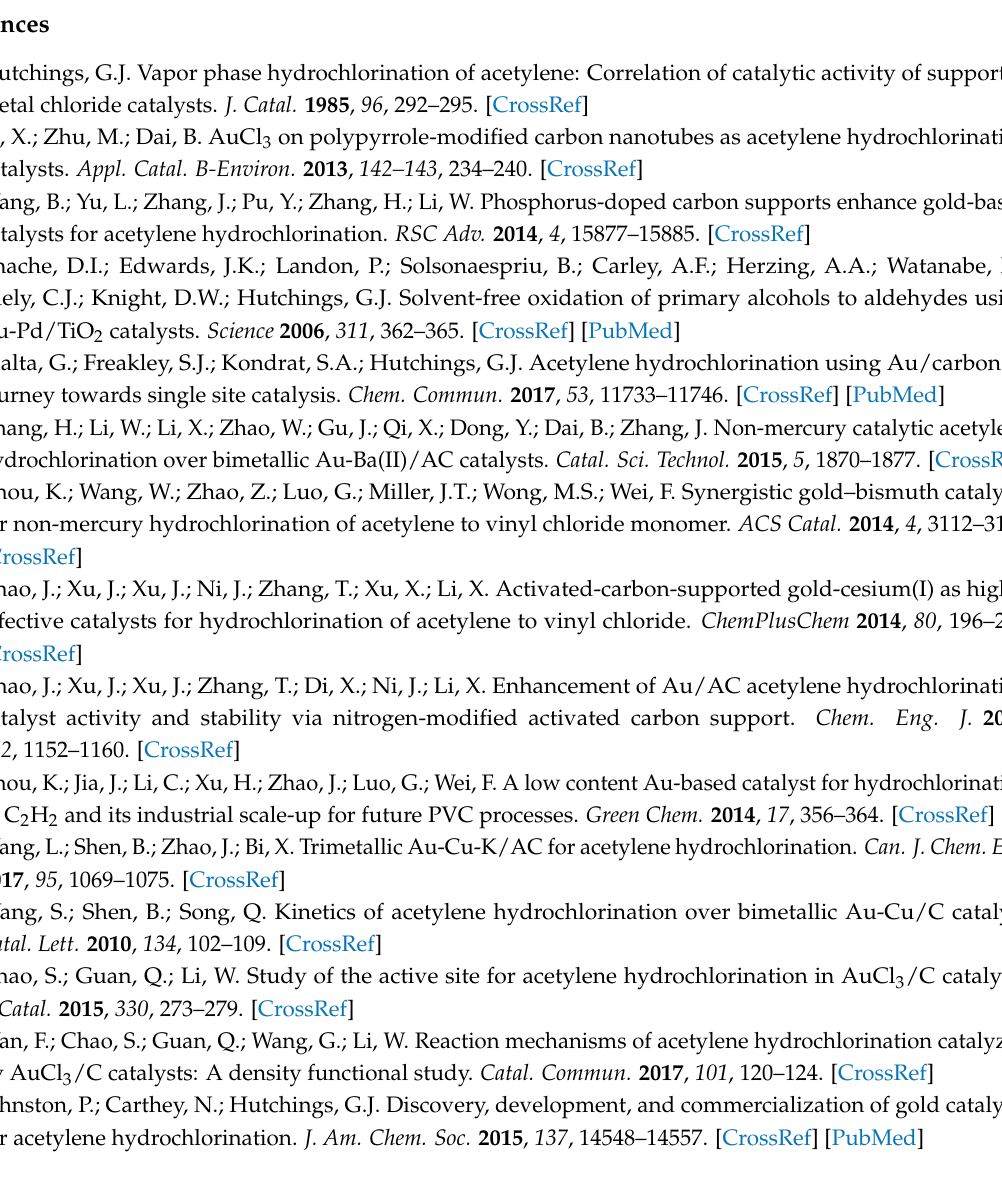
Table S3: Comparative study for the catalytic efficiency of this catalytic system over the literature reported ruthenium-based catalysts, Figure S1: The acetylene conversion (a) and selectivity to VCM (b) over the supports, Figure S2: The acetylene conversion of the Ru-P(Cy) 3 /AC catalyst, Figure S3: FT-IR spectra of the supports: (a) AC, (b) AC-HNO 3 , (c) AC-HCl, Figure S4: Nitrogen adsorption-desorption isotherms of the fresh (a) and spent (b) catalysts, Figure S5: Thermogravimetric analysis (TGA) curves of fresh and spent catalysts recorded in air atmosphere, Figure S6: Particle size distribution of Ru-based catalysts, Figure S7: The deconvoluted H 2 -TPR profiles of the fresh catalysts: (a) Ru/AC, (b) φ -P-Ru/AC, (c) φ -P-Ru/AC-HCl, (d) φ -P-Ru/AC-HNO 3 , Figure S8: High-resolution XPS spectra of Ru 3p for the fresh and spent catalysts, Figure S9: The activity of the catalyst regenerated by HCl and nitric